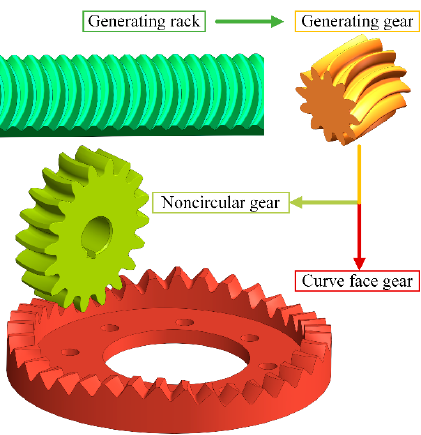
Figure 11. The tooth surface generating process of curve face gear pair. (1) Tooth surface equation of the generating rack The tooth surface Σ r of the generating rack includes straight tooth, helical tooth, and curvilinear tooth. Figure 12 is the tooth surface coordinate system when the tooth profile is a helical tooth or curvilinear tooth. When the helix angle β r is 0, it is a straight tooth generating rack. Figure 12. The tooth surface coordinate system of generating rack.